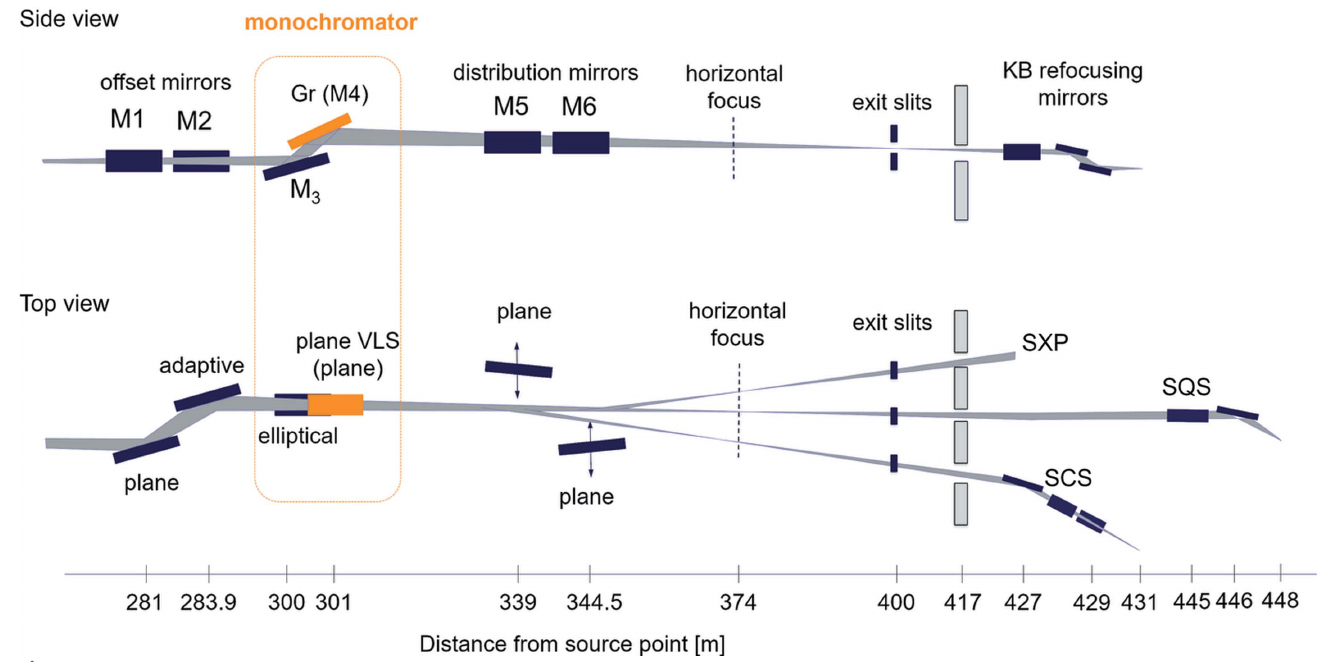
Figure 1 Layout of the SASE3 beamline, adapted from the work by Sinn et al.